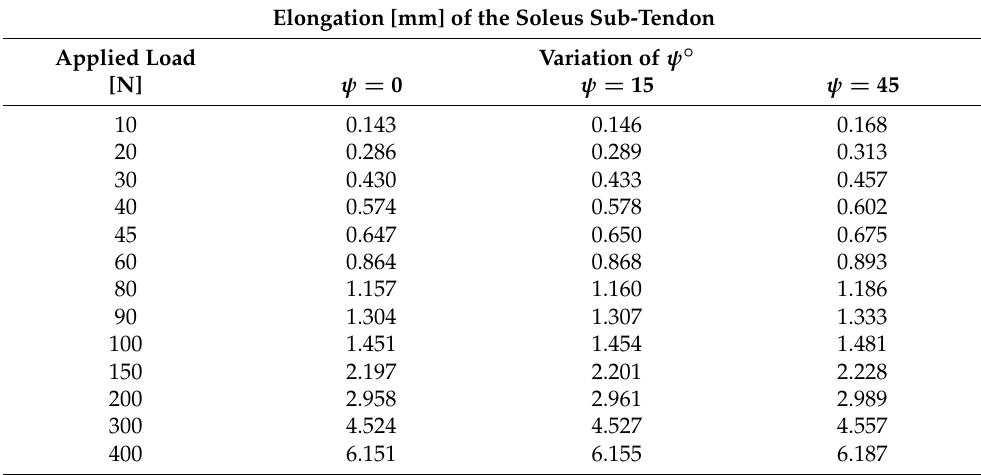
Table 1. The elongation test results in [mm] for the straight and pretwisted soleus subtendon of Type III tendons from the neo-Hookean material model. Elongation [mm] of the Soleus Sub-Tendon Applied Load